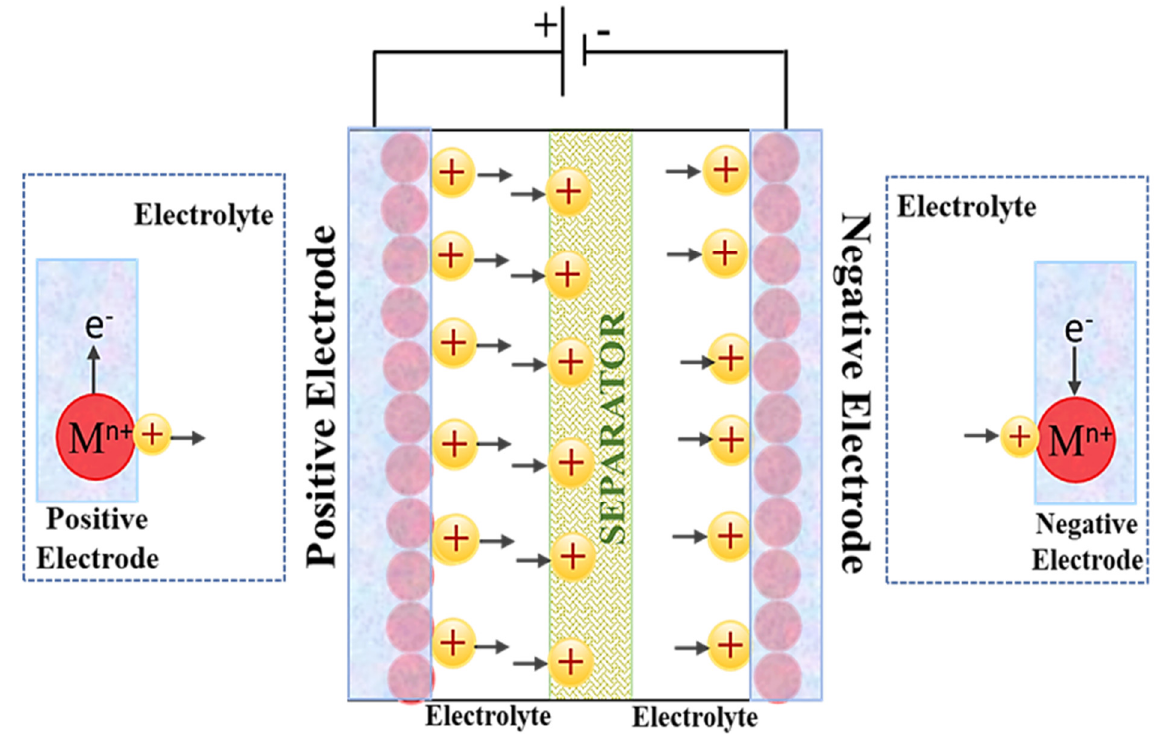
Figure 4. Schematic of the charge storage phenomenon of pseudo-capacitors.